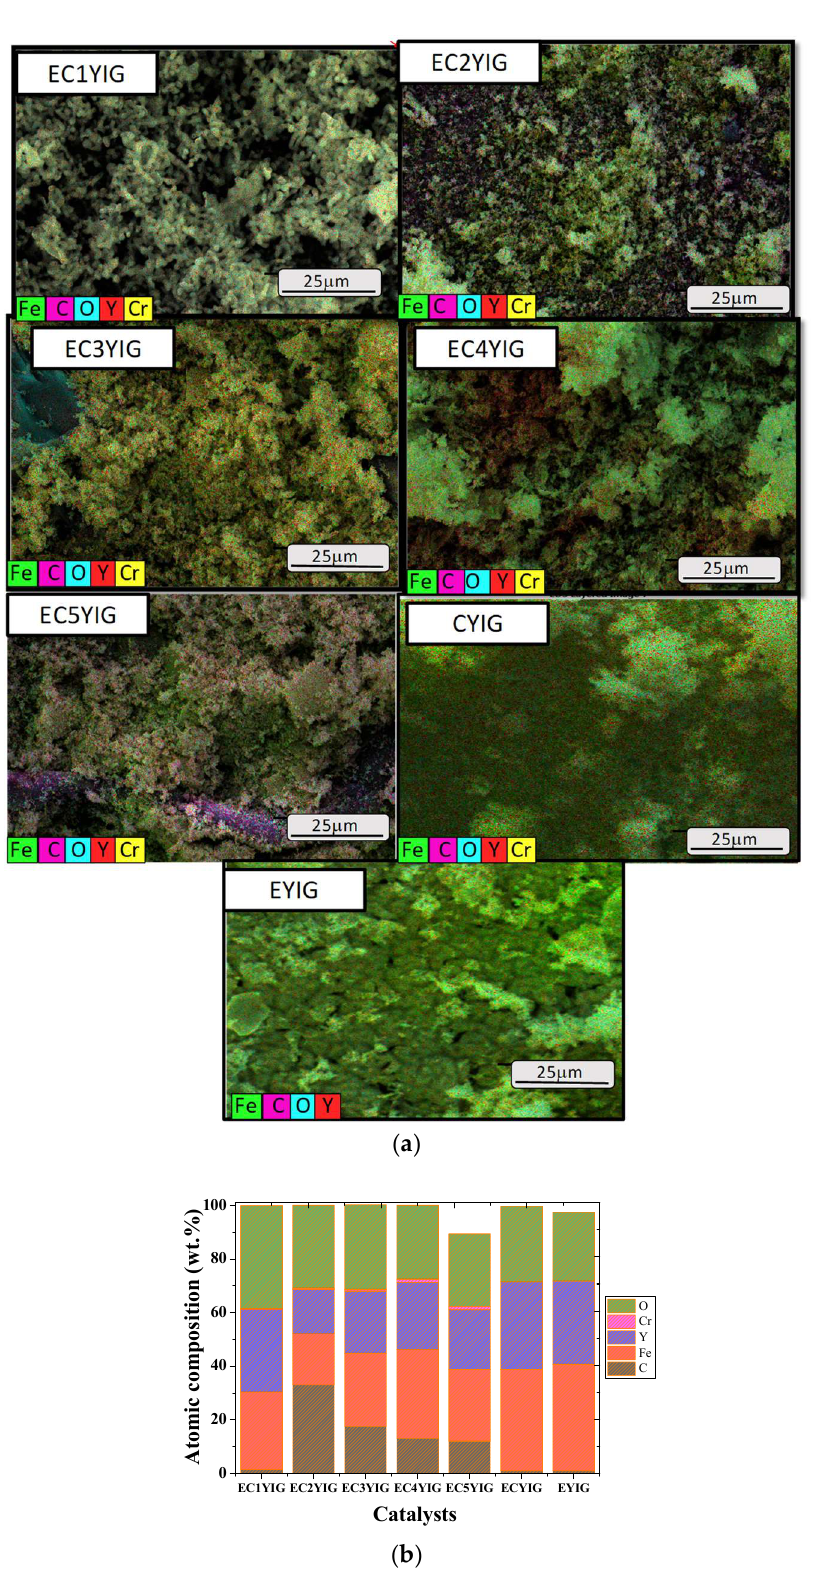
Figure 7. ( a ) Elementary maps and secondary electron images convolution. ( b ) Composition taken from EDS spectra of the spent yttrium iron garnet ferrites. Reaction conditions: EB to H 2 O 2 molar ratio of 1 using 1.3 mol of acetone as solvent, temperature of 50 °C and a catalyst mass of 50 mg within 360 min of reaction.